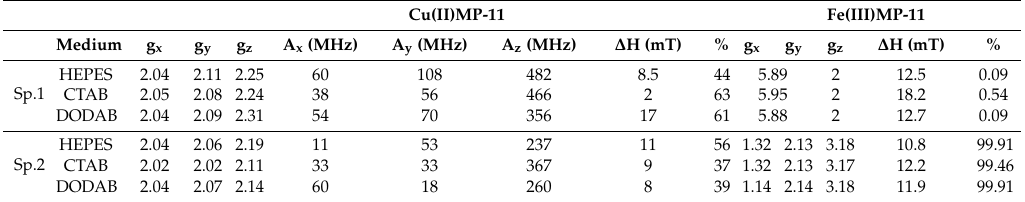
Table 2. EPR parameters obtained from simulation of experimental spectra using